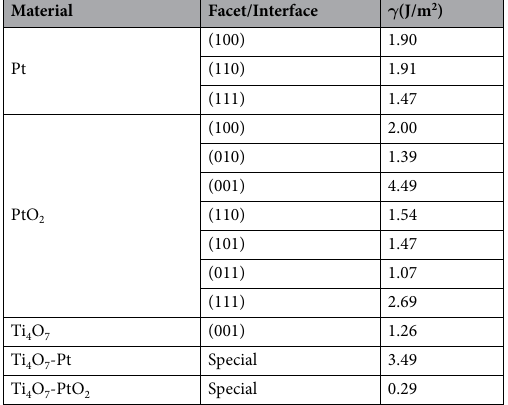
Table 1. The calculated surface formation energy or interface formation energy. ‘Special’ indicate the facets to have the Ti sub-lattice aligned with the Pt sub-lattice as illustrated in Fig.